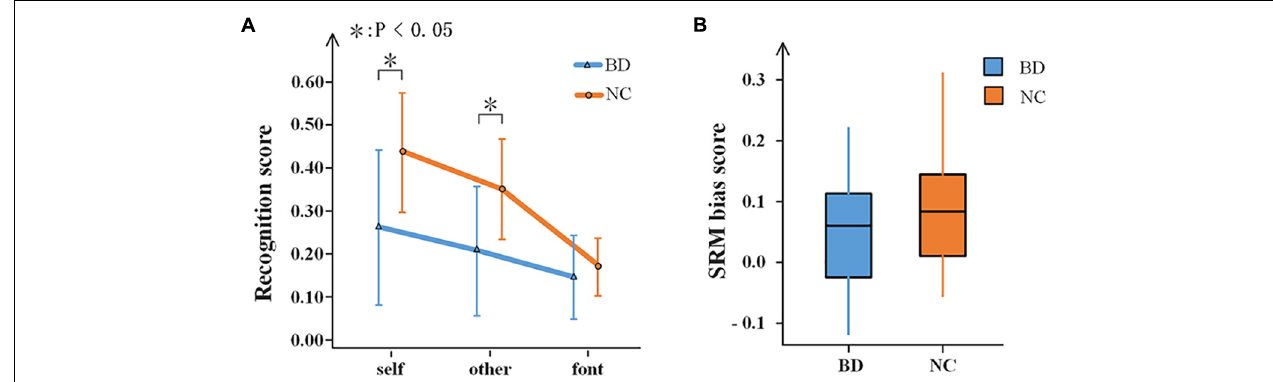
FIGURE 2 | Behavioral results. (A) Recognition scores of BD and NC under the three experimental conditions. Error bars indicate the standard deviations. (B) A box-plot of the SRM bias scores in BD and NC. SRM, self-referential memory; BD, bipolar disorder; NC, normal control.